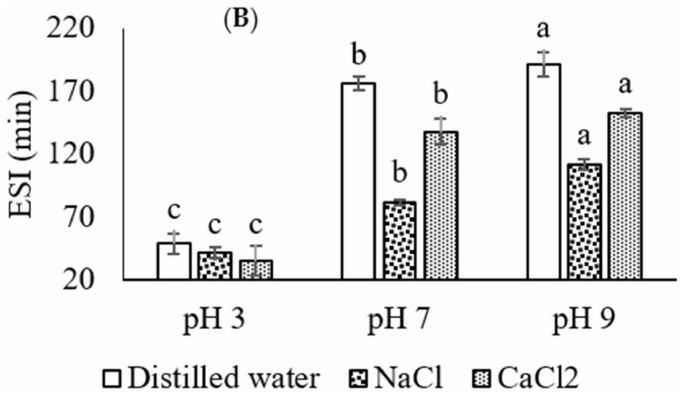
Figure 2. Emulsifying activity index ( A ) and emulsifying stability index ( B ) of API at different pH mediums in distilled water and in the presence of NaCl and CaCl2. Different letters (a–c) represent significant differences among data. The significant difference was calculated individually among each